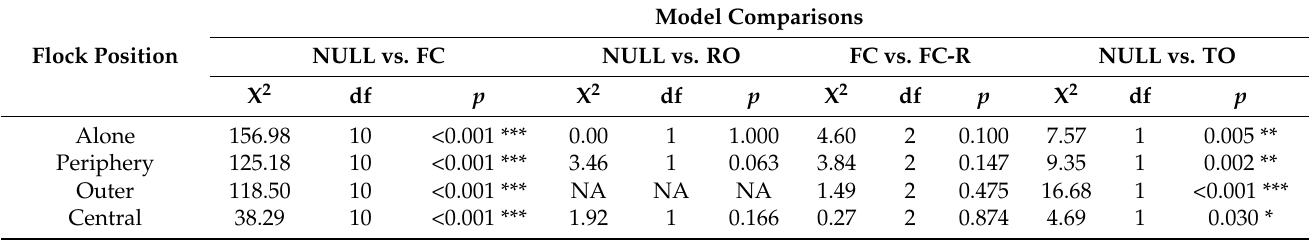
Figure 5. Average monthly time-flock position budgets of individual foster-reared chicks, foster-reared chicks as a group (FOS), and grouped female and male parent-reared chicks (PAF and PAM, respectively). Red = alone; green = periphery; yellow = outer; grey = central. Standard error bars represent variation within grouped chicks. Chicks spent most of their in peripheral and outer positions to the flock. Over time chicks were less likely to be found in alone and peripheral positions, and more likely to be found in outer flock positions. Table 4. Comparison of model performance between binomial GLMMs predicting position within